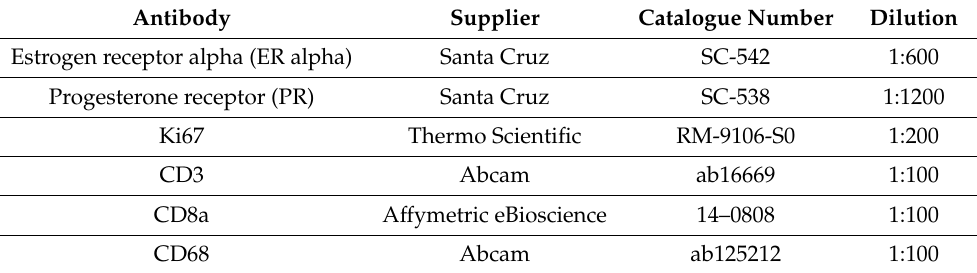
Table 2. Antibodies used for